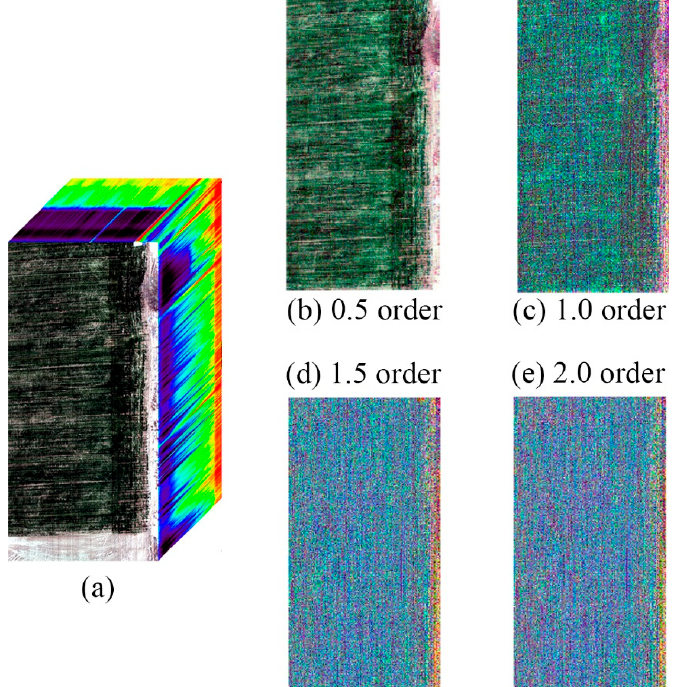
Figure 3. Results based on different FOD-preprocessed hyperspectral images. Shown here are RGB images, with the red, green, and blue bands being R 659 , R 550 , and R 479 , respectively. ( a ) Hyperspectral image cube. ( b – e ) Processing results from the orders of 0.5, 1, 1.5, and 2.